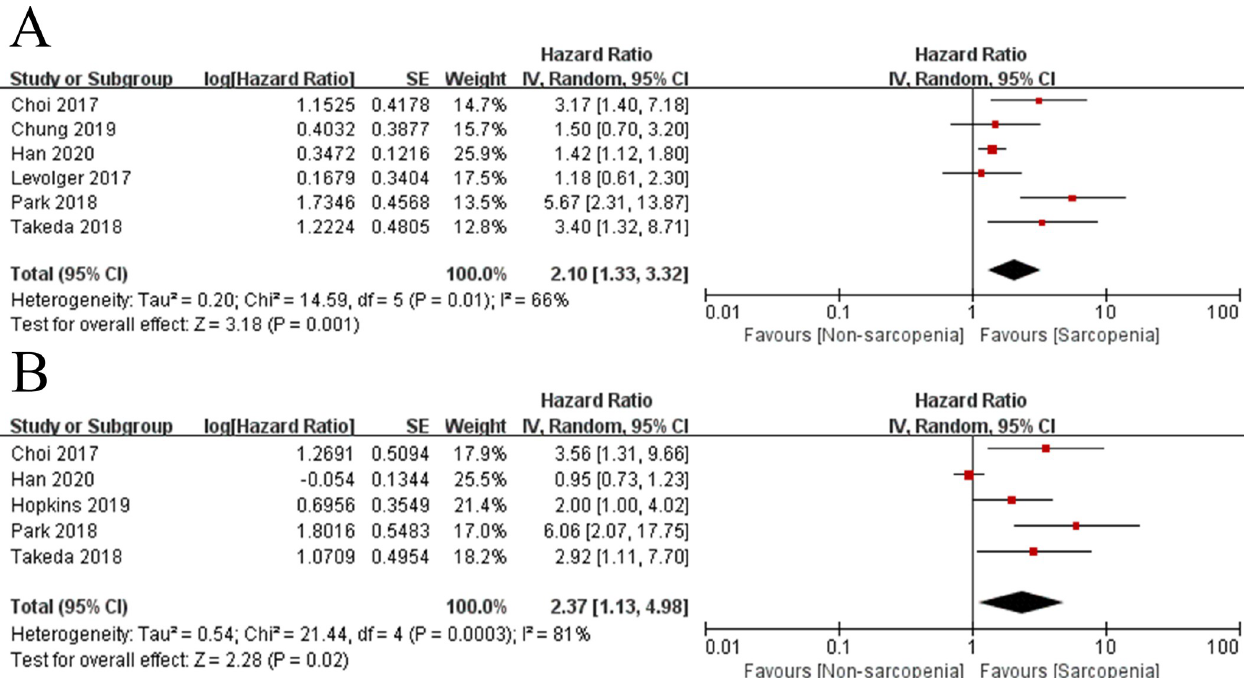
Fig 2. Forest plots of hazard ratios for overall survival in rectal cancer patients with sarcopenia versus those without. (A) univariate data, (B) multivariate data.